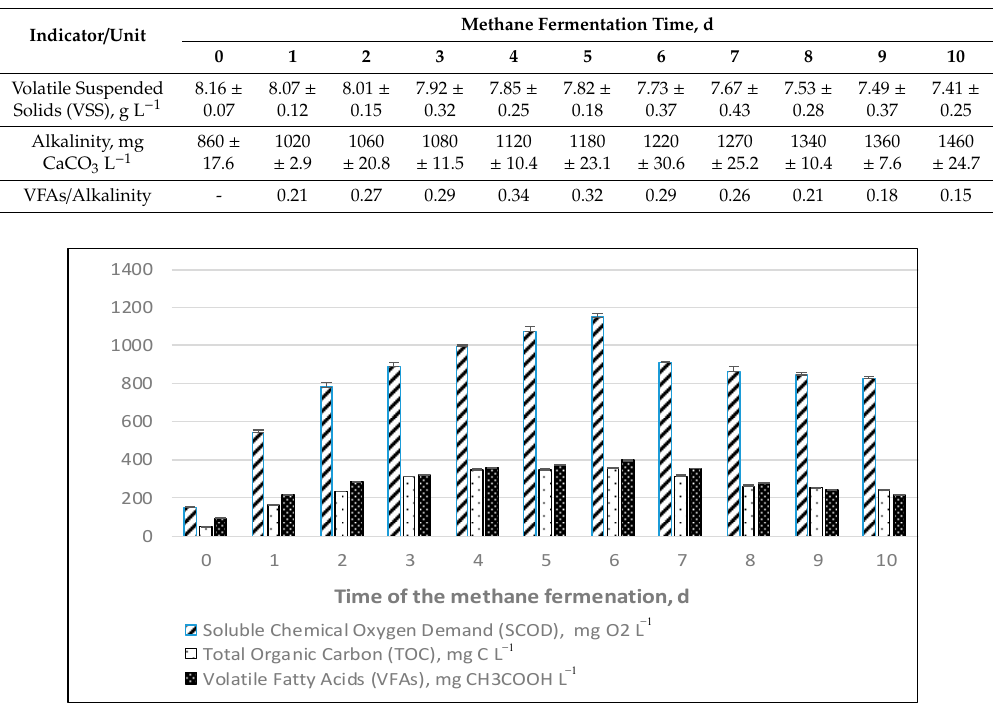
Figure 4. Changes of SCOD, TOC, and VFAs values in the methane fermentation process of unprepared excess sludge.